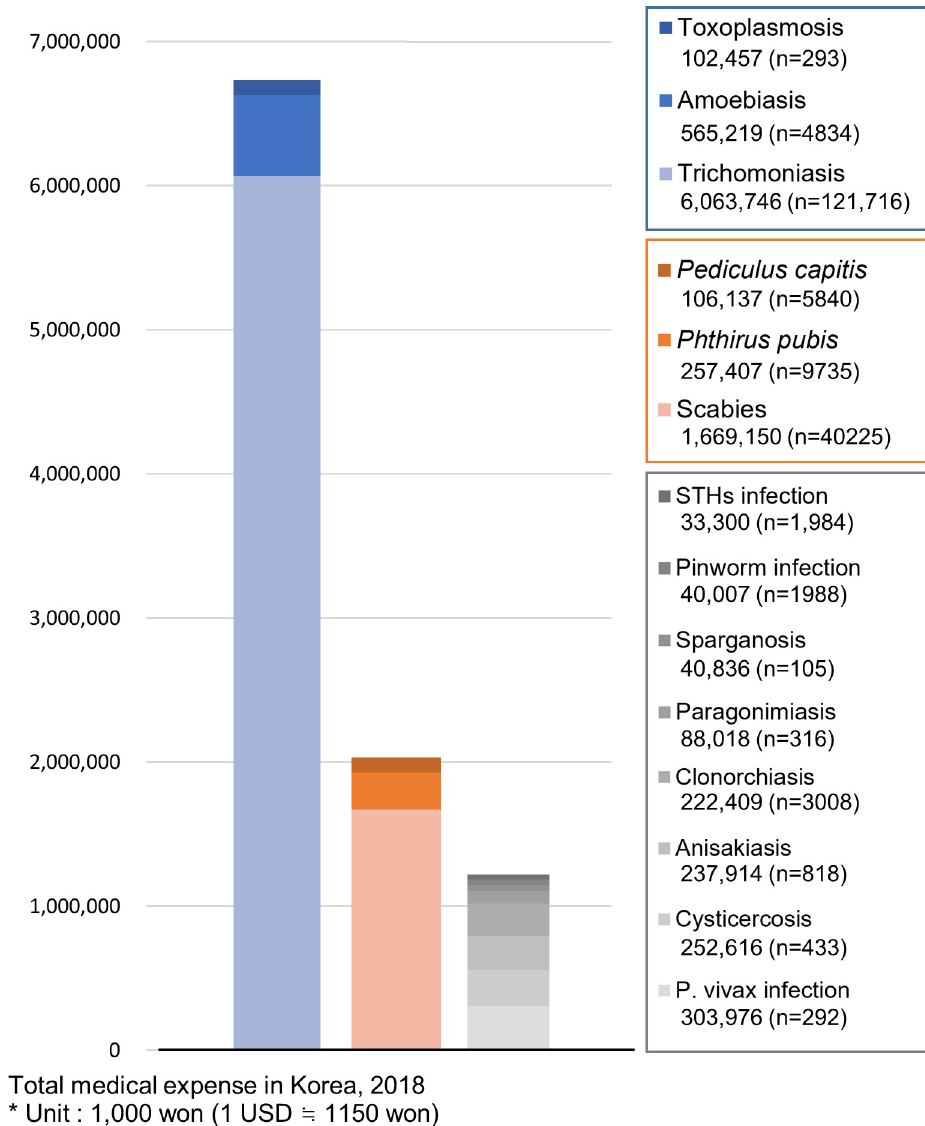
Fig 5. Total medical expense in South Korea due to parasitic diseases in 2018: globally distributed protozoan diseases (blue), ectoparasite infestations (orange), and endemic parasitic diseases (gray). The unit of money is 1,000 Korean won (1 US$ ≒ 1150 won). n = the number of